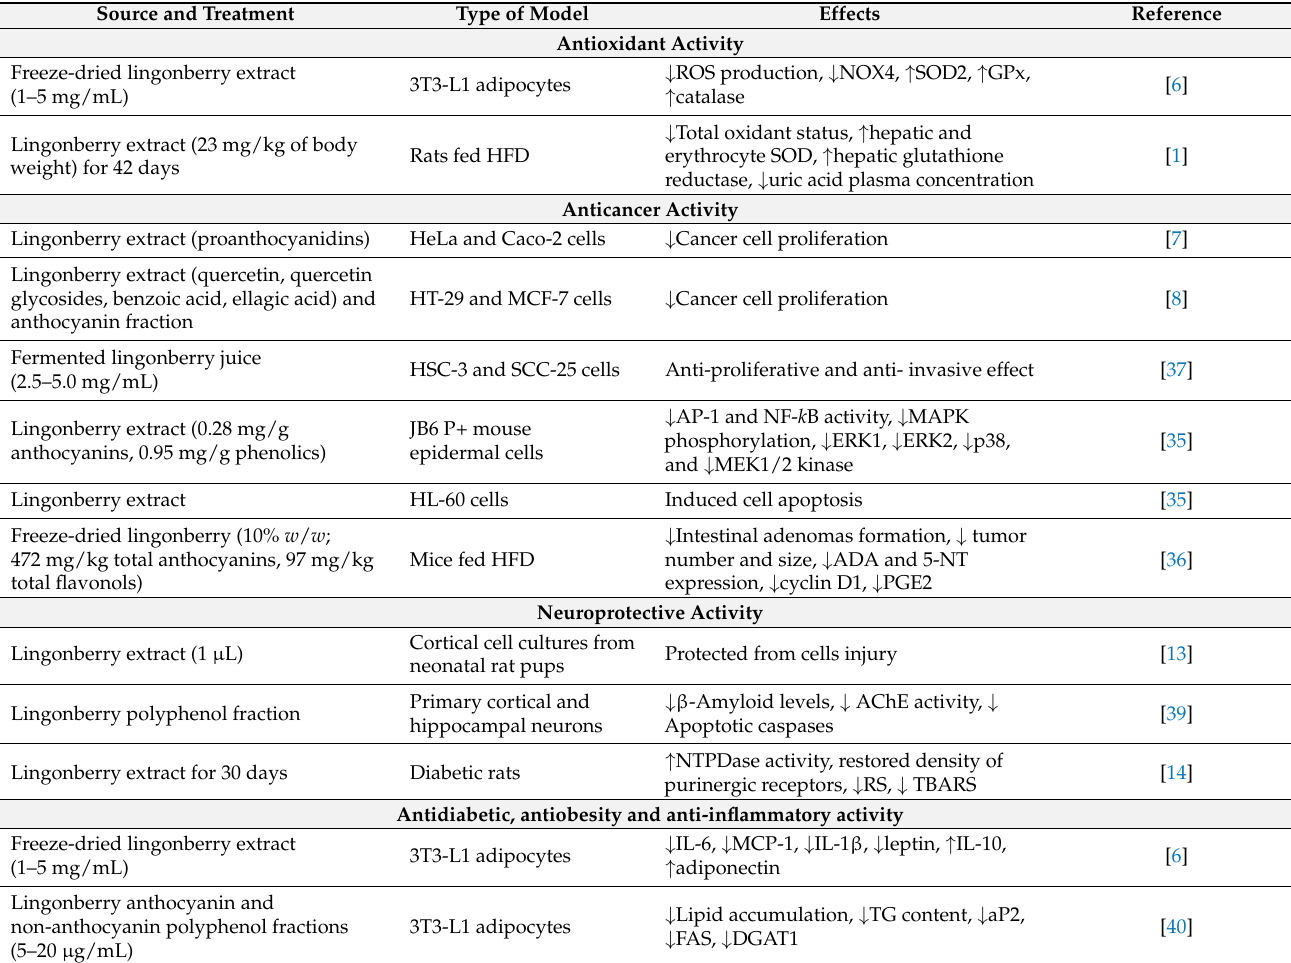
Table 2. Biological activity and the health effect of lingonberry